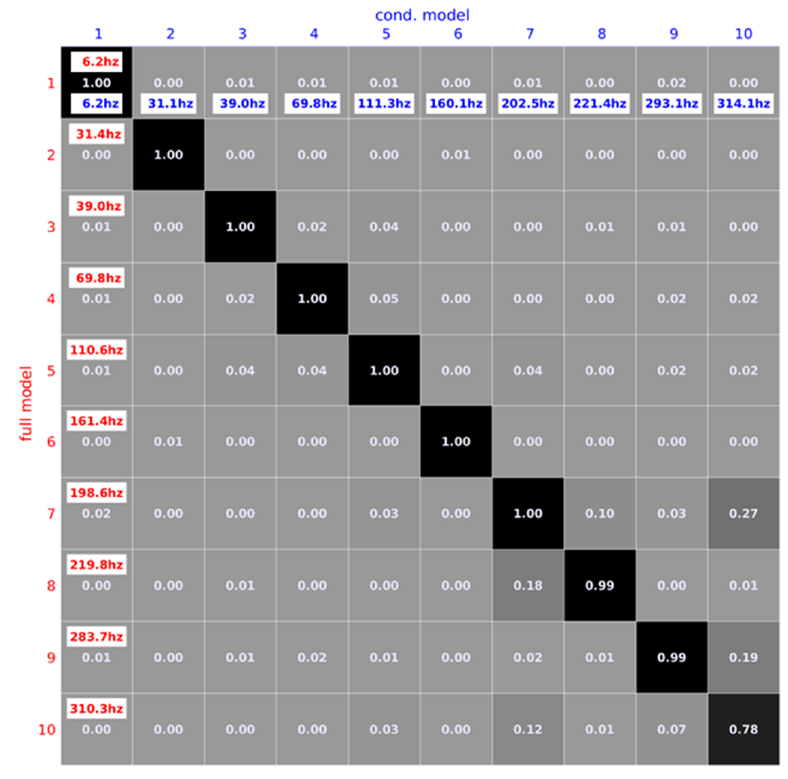
Figure 11. Modal assurance criterion (MAC) matrix of full and condensed model.